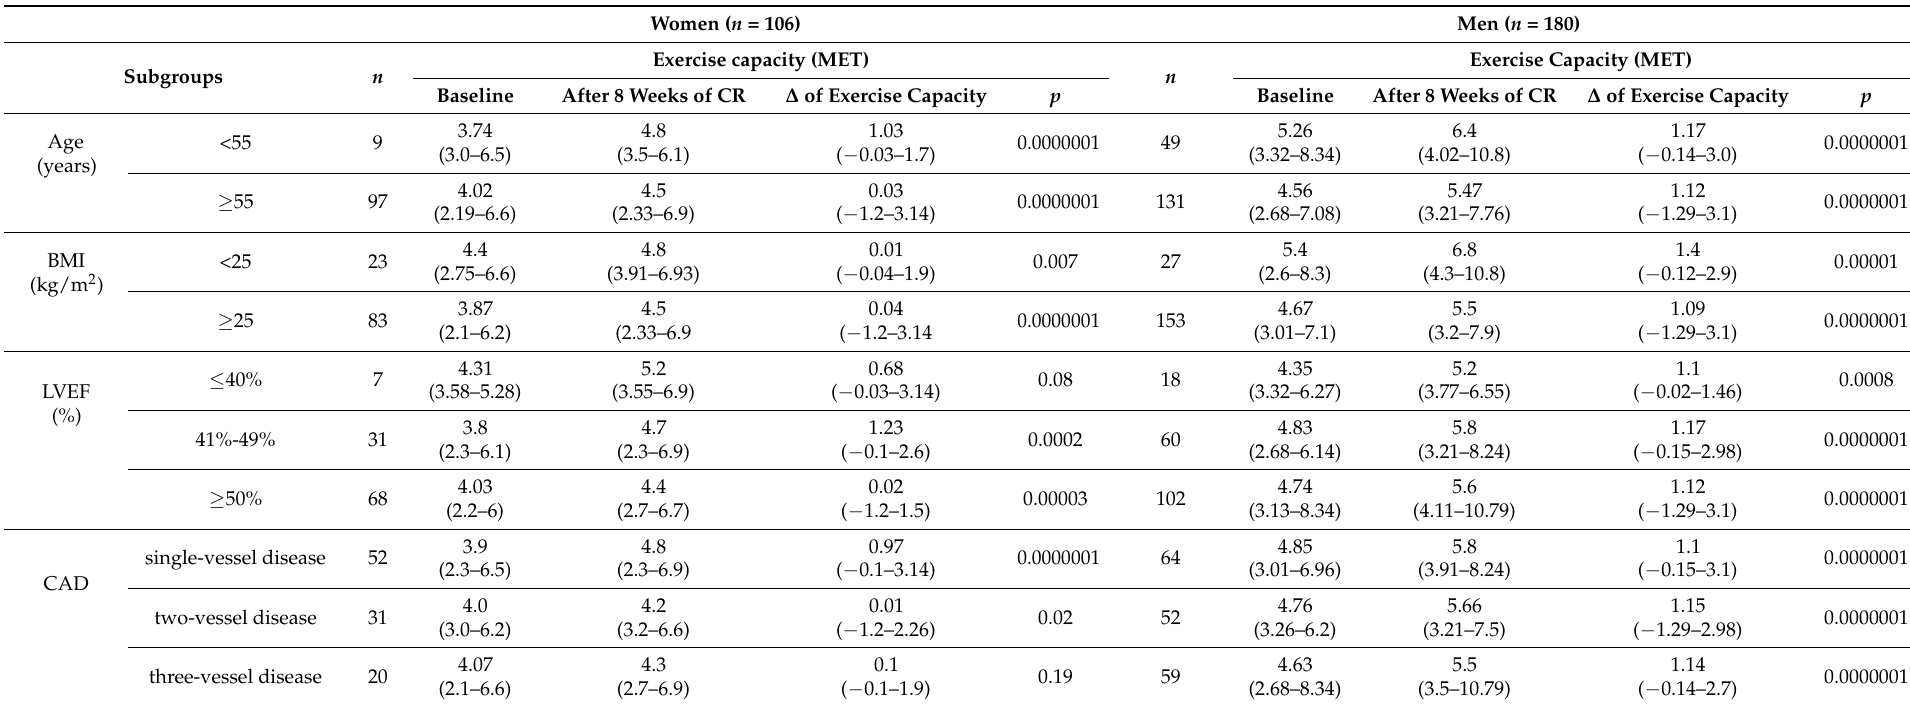
Table 5. The exercise capacity of examined women and men with CAD at baseline and after 8 weeks of CR program in created